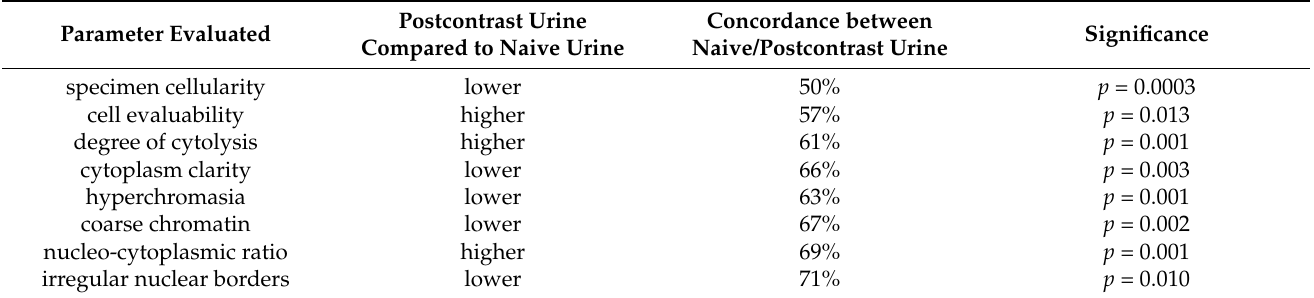
Table 5. Evaluation of cytological